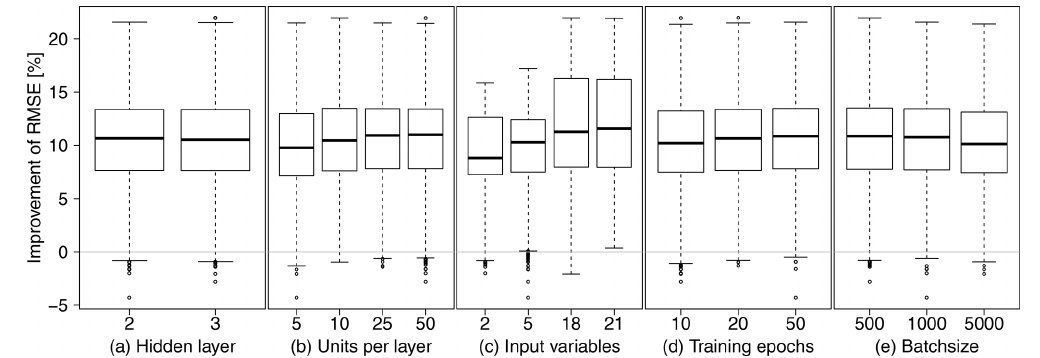
Figure A1. RMSE improvements against COSMO-REA6 for all 12 models with five repetitions grouped by (a) number of hidden layer, (b) units per layer, (c) input variables, (d) training epochs and (e) batch